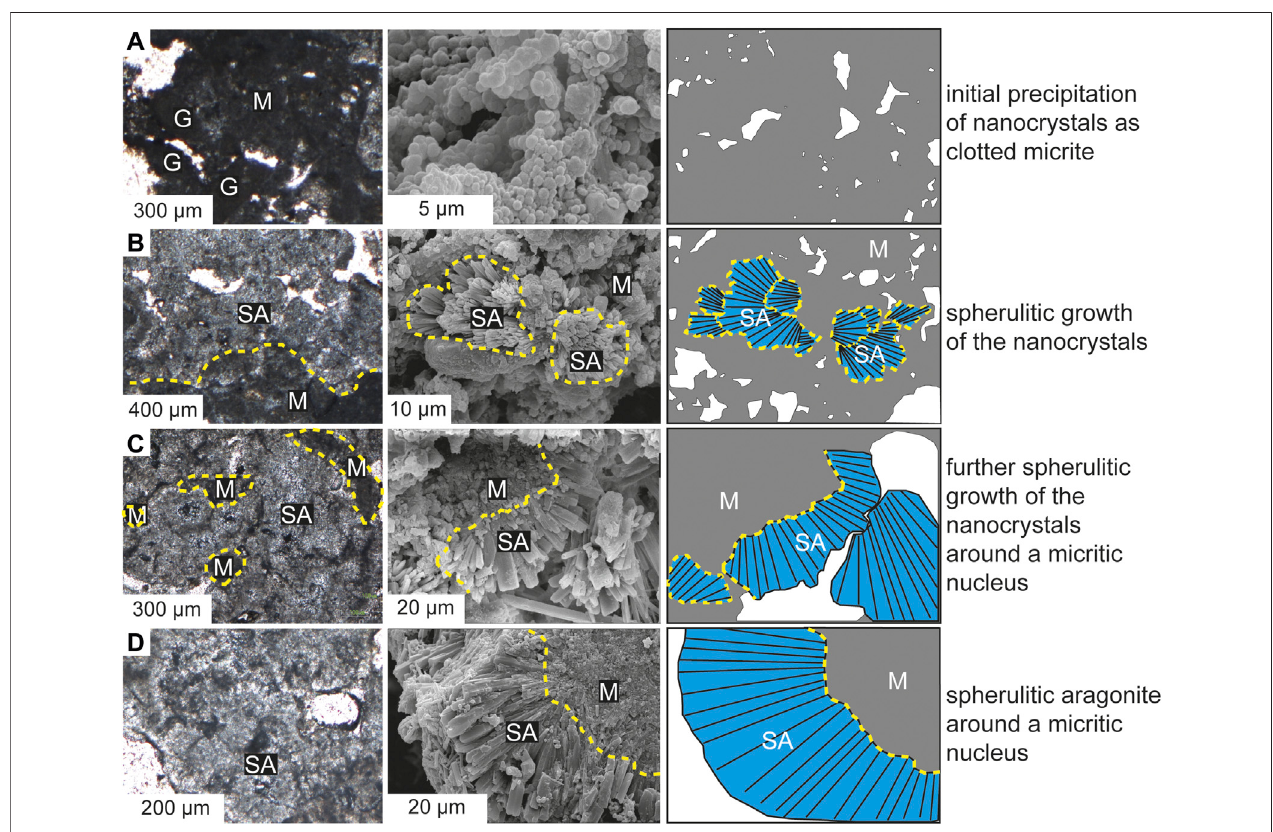
FIGURE 6 | Evolutionary steps from nanocrystals forming part of clotted peloidal micrite to botryoidal and spherulitic aragonite via precipitation and aggregation in Great Salt Lake microbial bioherms showing thin section image (left) , SEM image (middle) and sketch (right) . M-micrite, SA-spherulitic aragonite. In (A) , the clotted micriteconsistsofnumerousnanocrystalswitharandomdistribution.In (B) ,aragonite fi bersofspheruliticaragonitegrowoutfromnanocrystalsofmicrites, andirregular contacts are between both. In (C) , aragonite fi bers continue to grow on the micrite nucleus. In (D) , spherulitic aragonite increases in size and associated micrite decreases in